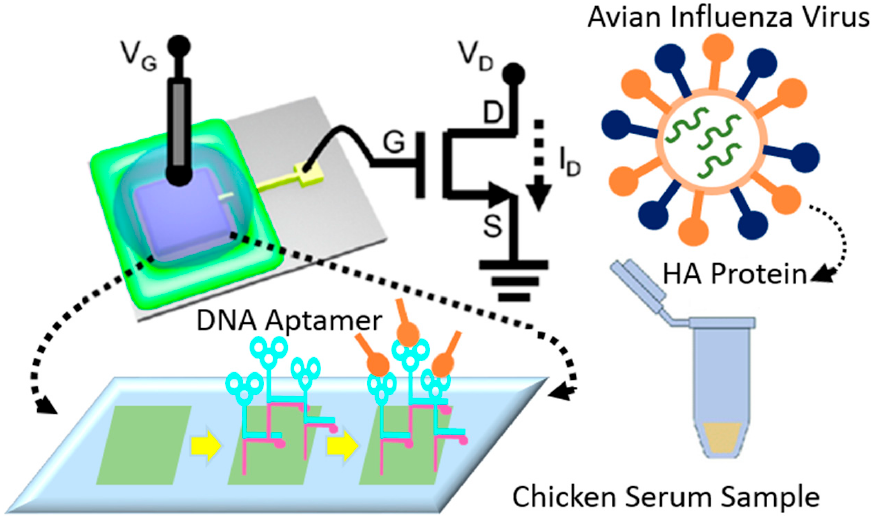
Figure 20. The illustration of the FET-based aptasensor for detecting AIV in chicken serum. The surface of the gold electrode was modified with specific DNA aptamers for identifying the surface protein of the virus. The interaction between the probe and the target resulted in the structural change of the aptamers which was recorded as the surface potential.